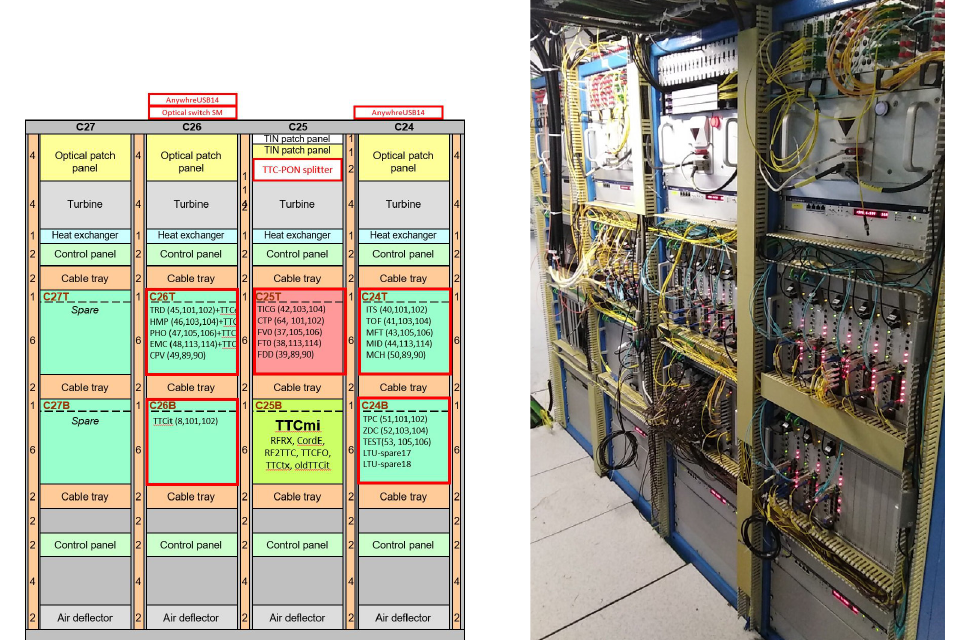
Figure 6. Central Trigger System overview with layout (left) and installation at point 2